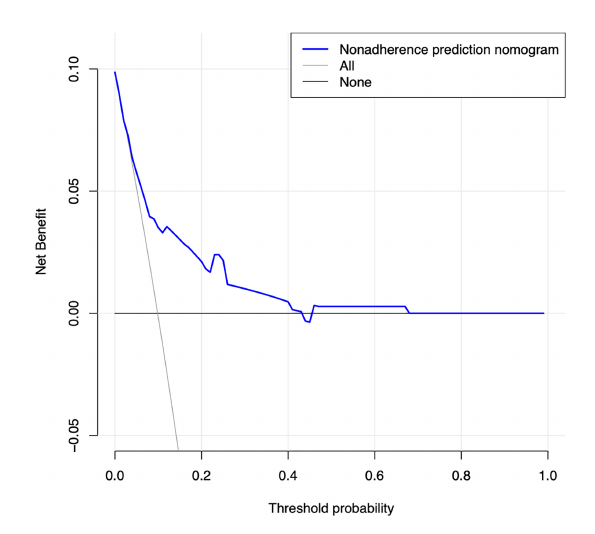
FIGURE 4 Decision curve analysis for the predictive nomogram of diabetes mellitus. The y-axis measures the net bene fi t. The dotted line represents the risk of predictive nomogram. The thin solid line represents the assumption that all patients have diabetes mellitus. Thin thick solid line represents the assumption that no patients have diabetes mellitus. The decision curve demonstrates that if the threshold probability of a patient and a doctor is >2% and <68%, respectively, using this nomogram to predict diabetes mellitus of IIMs adds more bene fi t than the